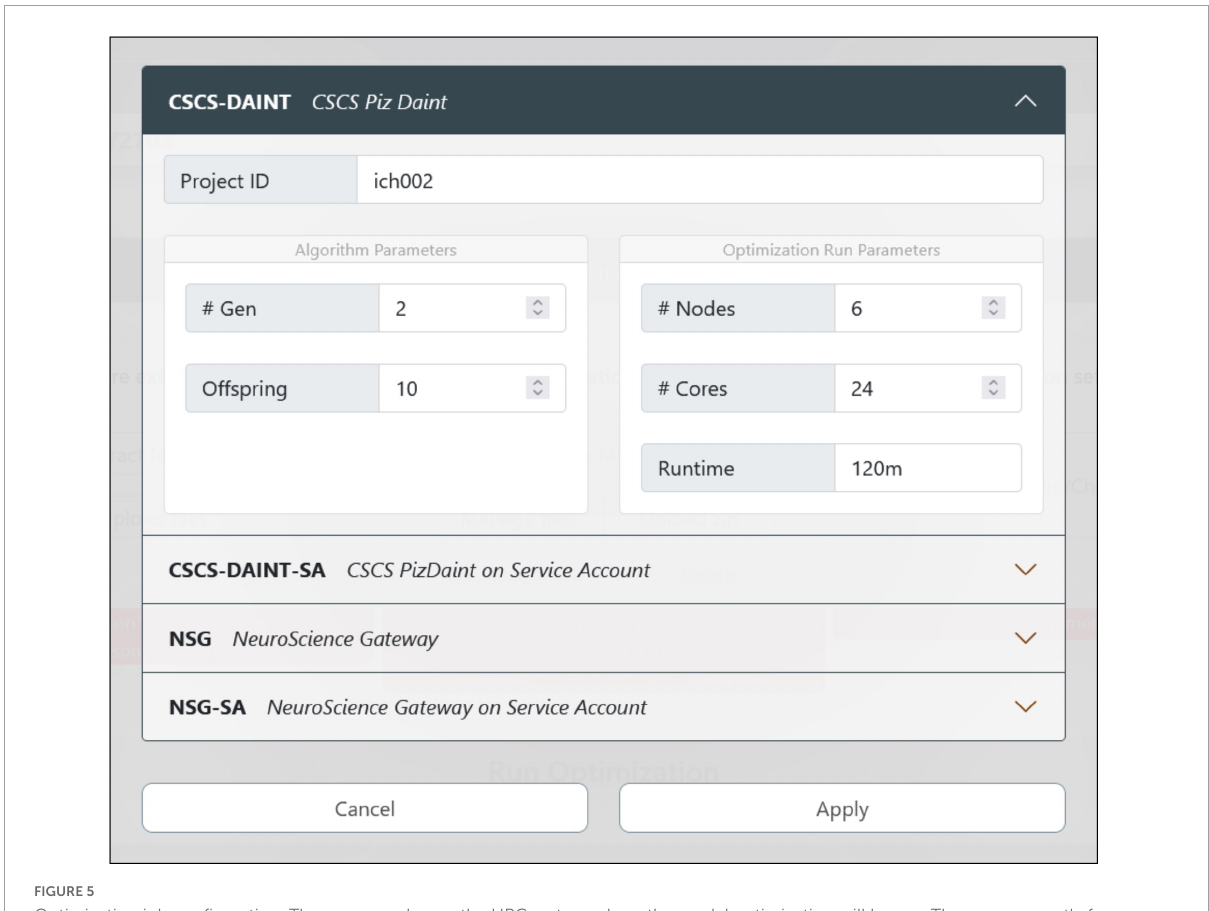
FIGURE5 Optimization job configuration. The user can choose the HPC system where the model optimization will be run. There are currently four options available: If the users already have an account (and is part of a project) on the CSCS or NeuroScience Gateway (NSG) supercomputers, they can use their own credentials and quota for the execution of the job. While using NSG requires the insertion of username and password, the CSCS and EBRAINS users’ accounts are automatically mapped together so that no credential insertion is required. In case the users do not have their own account on any of the available HPC systems, they can submit the job via the CSCS or NSG service accounts that only require a registration on the EBRAINS platform (to generate a user token at runtime) and provide a limited quota for job